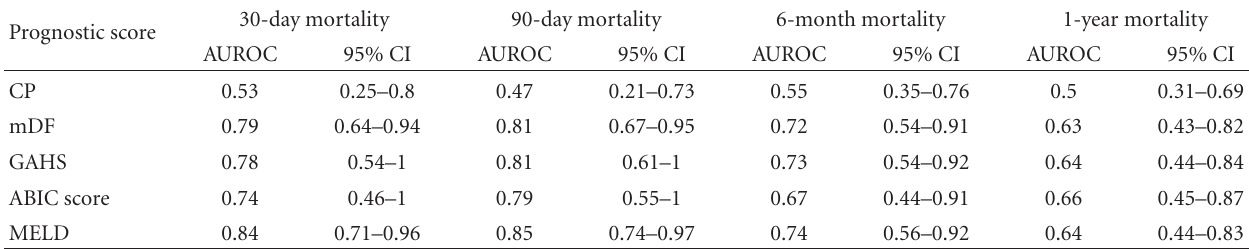
Table 4: The area under the receiver operating characteristic (AUROC) for prognostic scores for short- and long-term mortality in patients with